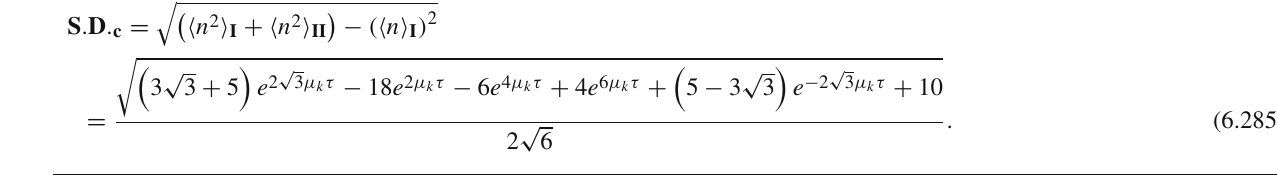
Fig. 50 Time dependent behaviour of the third moment (cid:14) n 3 (cid:15) for different fixed values of the parameter μ